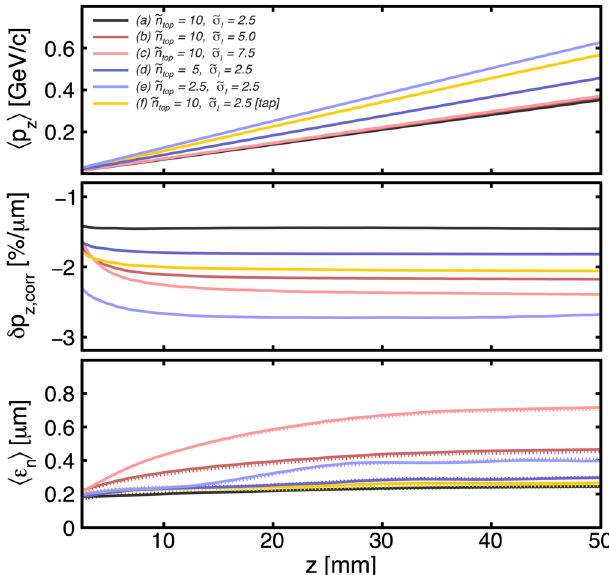
FIG. 9. (Top) Average longitudinal momentum, (middle) cor- related relative energy spread and (bottom) average slice emit- tance of the witness bunches as a function of acceleration distance for the selected simulation